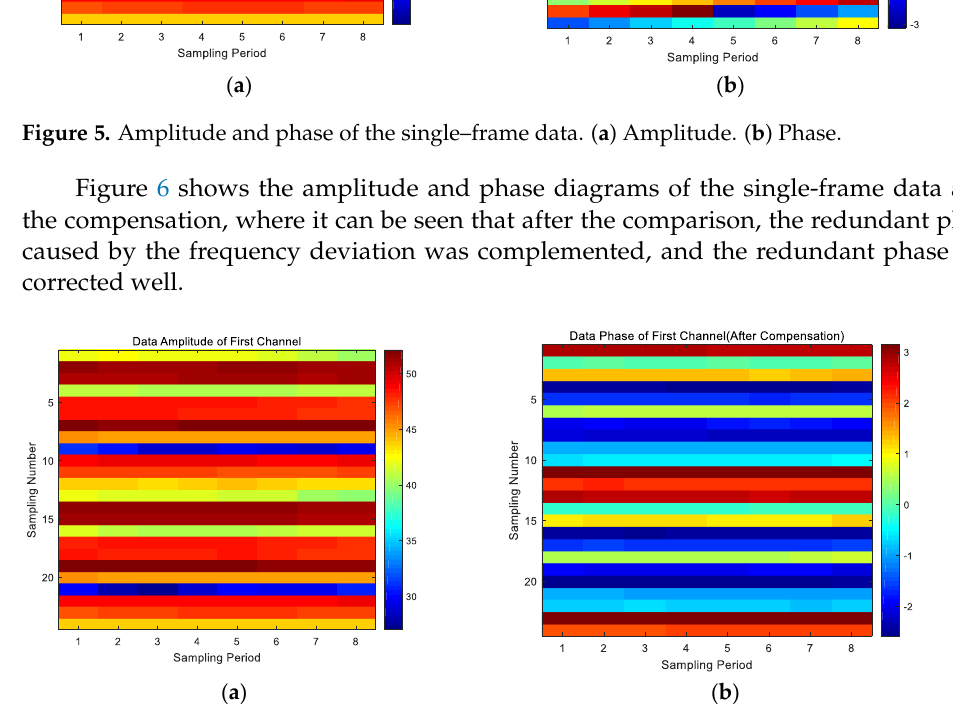
Table 1. Influence of different frequencies on positioning results.